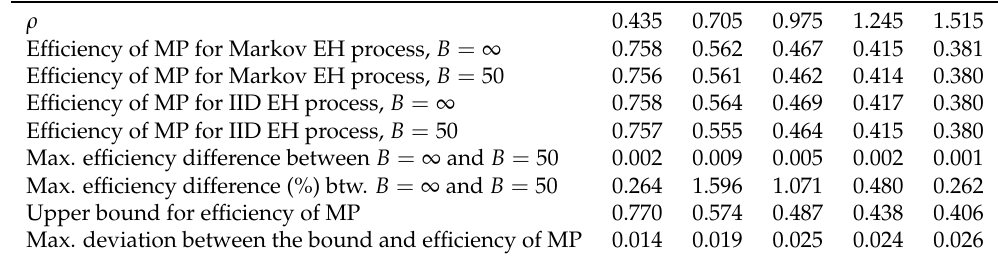
Table 3. Efficiency of MP for IID and Markov EH processes under both infinite and finite capacity battery assumptions B = ∞ and B = 50 stands for infinite and finite capacity batteries, respectively. ρ denotes the intensity. Max. efficiency difference between B = ∞ and B = 50 represents the efficiency difference between B = ∞ and B = 50 cases for the same intensity. Max. efficiency difference (%) btw. B = ∞ and B = 50 represents the percentage of efficiency difference between B = ∞ and B = 50 cases over the efficiency in B = ∞ case for the same intensity. Max. deviation between the bound and efficiency of MP represents the difference between the upper bound of efficiency of MP and minimum efficiency result of MP for the same